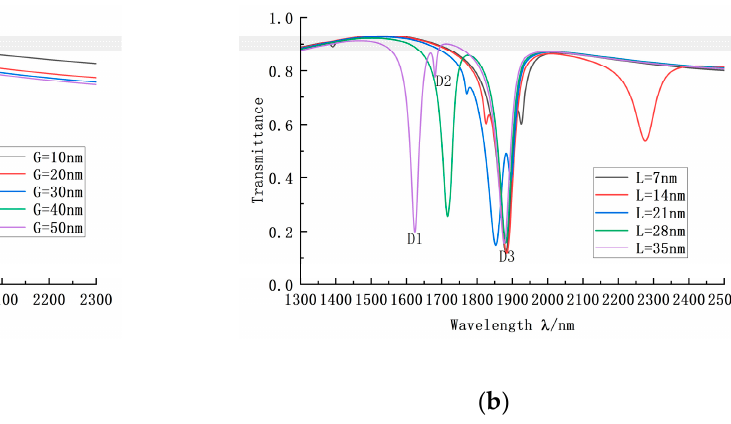
Figure 6. ( a ) Transmission curves of the IZRR structure at different coupling distances. ( b ) Trans- mission curve of the IZRR structure with different Z-structure spacing.